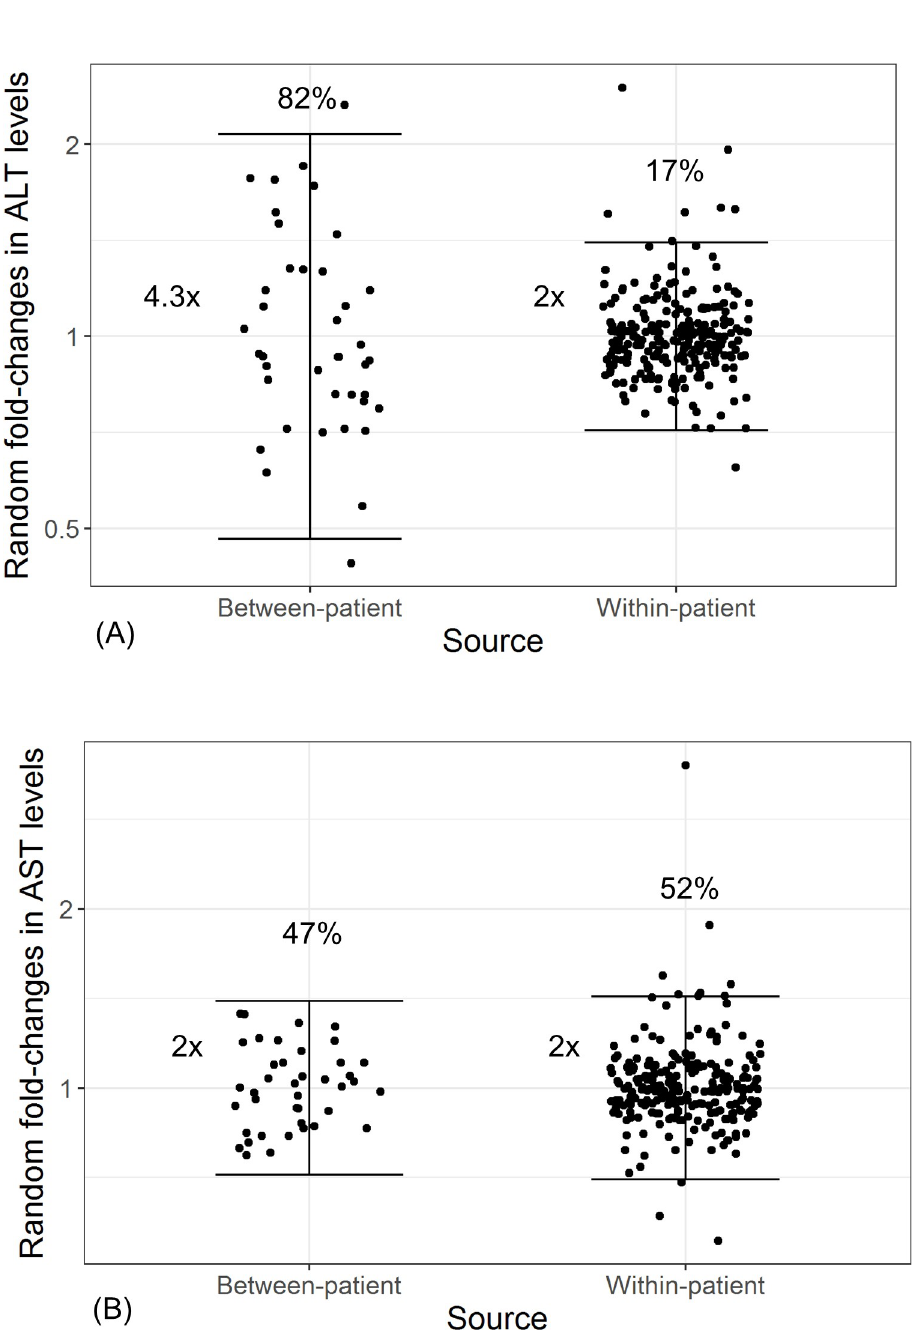
Fig 7. Variance component analysis of liver transaminases in serum from healthy volunteers. Variance component analysis of alanine transaminase (ALT) and aspartate transaminase (AST) are represented in panels A and B, respectively. Points represent random deviations from between-donor (left) and within-donor (right) means and brackets represent 95% reference ranges based of each variance component. Proportion of variance relative to the total is displayed above each variance